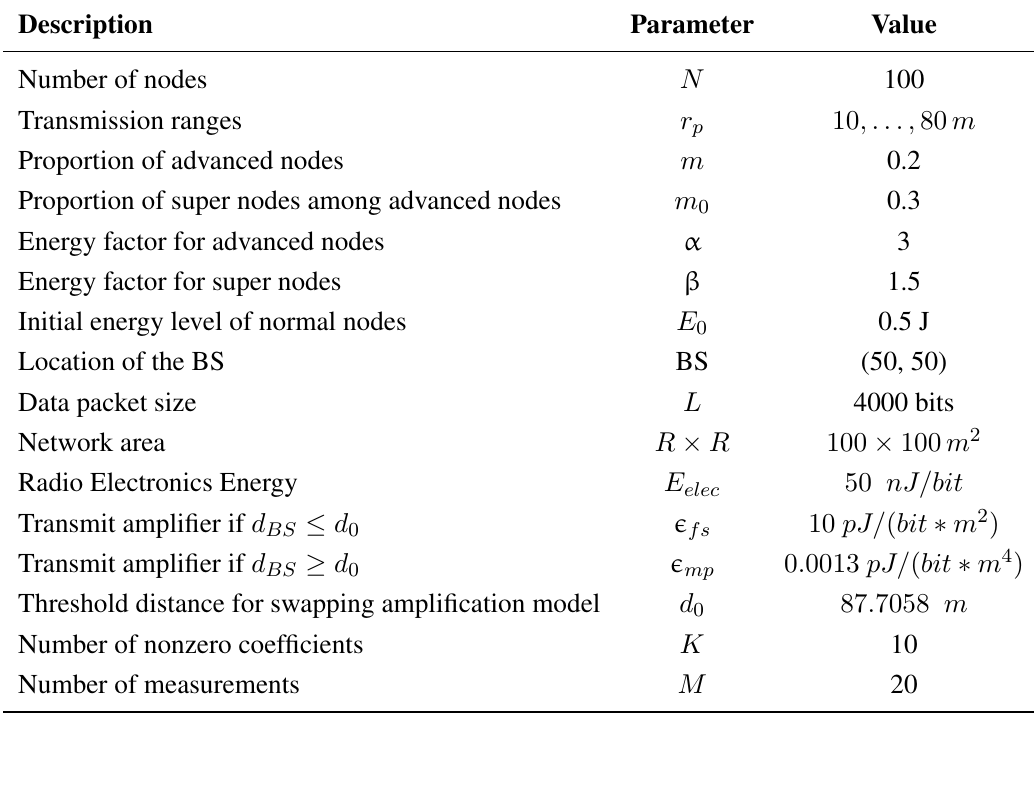
Table 1. Simulation Parameters.